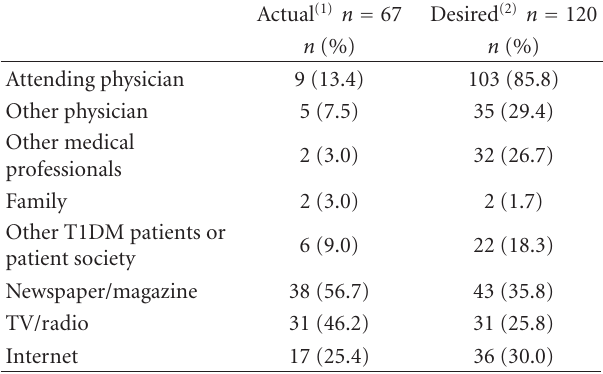
Table 1: Subject characteristics ( N = 137). Table 2: Actual/desired information sources islet